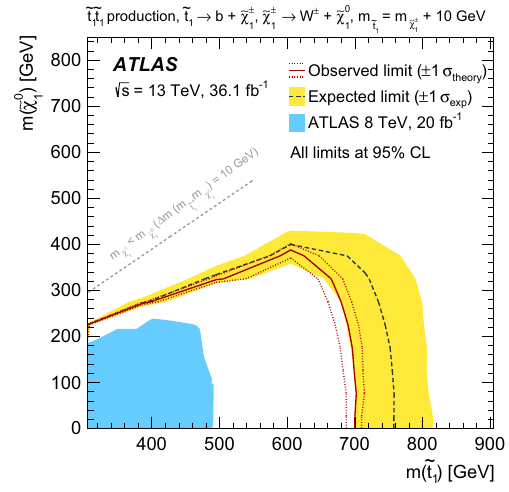
Fig. 9 Exclusion contour for a simplified model assuming ˜ t 1 pair pro- ( ∗ ) ˜ χ 0 duction, decaying via ˜ t 1 → t 1 with 100% branching ratio. The dashed grey line and the shaded yellow band are the expected limit and 1 . 1 its ± 1 σ uncertainty. The thick solid red line is the observed limit for the central value of the signal cross-section. The expected and observed limits do not include the effect of the theoretical uncertainties in the signal cross-section. The dotted lines show the effect on the observed limit when varying the signal cross-section by ± 1 σ of the theoretical uncertainty. The shaded blue areas show the observed exclusion from √ s = 8 TeV analyses [18] the ATLAS